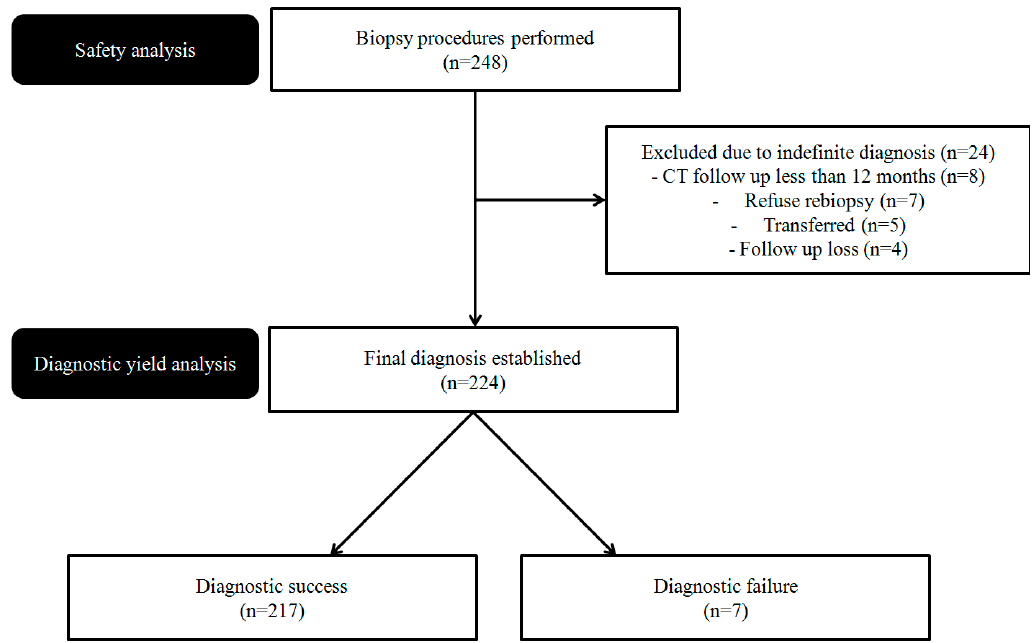
Figure 1. Study Figure 1. Study flowchart.